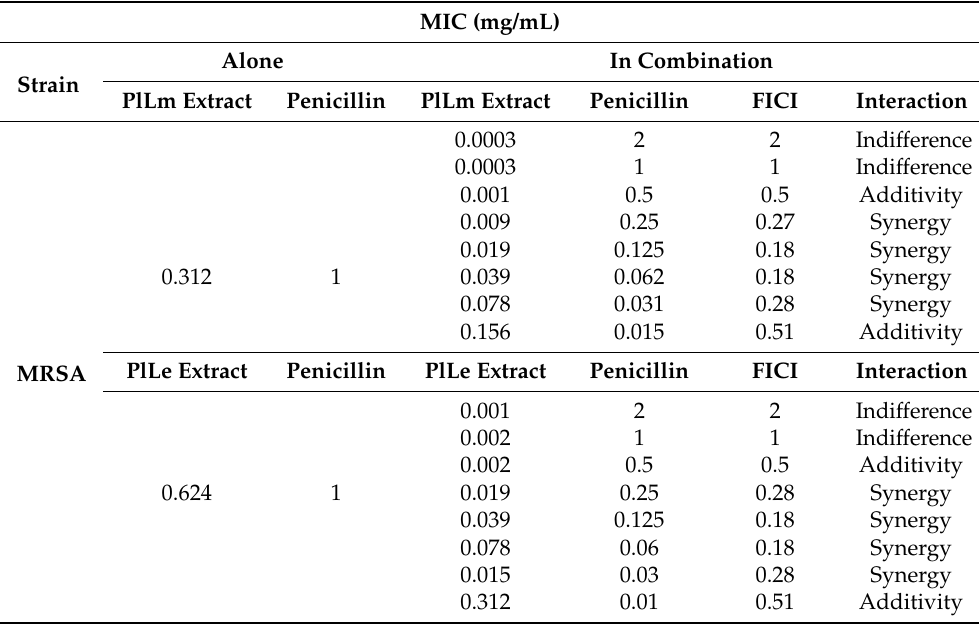
Table 3. Fractional inhibitory concentration index (FICI) of the P. longifolia extracts/penicillin combi- nation against the prx-MRSA-2018